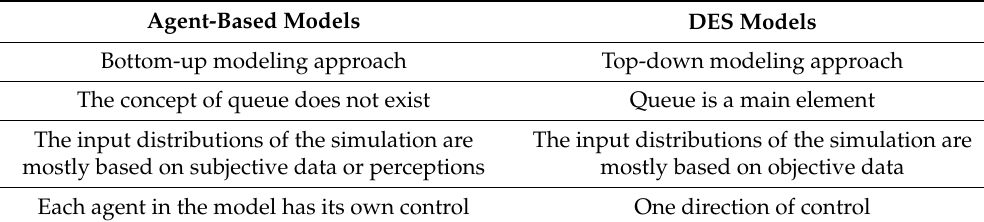
Table 1. Important attributes of agent and discrete model